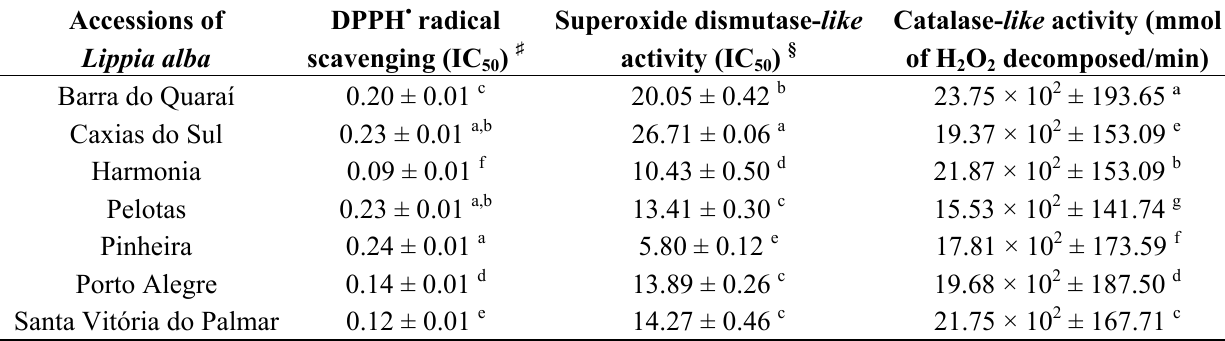
Table 3. DPPH • radical scavenging, superoxide dismutase- like and catalase- like activities in different accessions of Lippia alba .